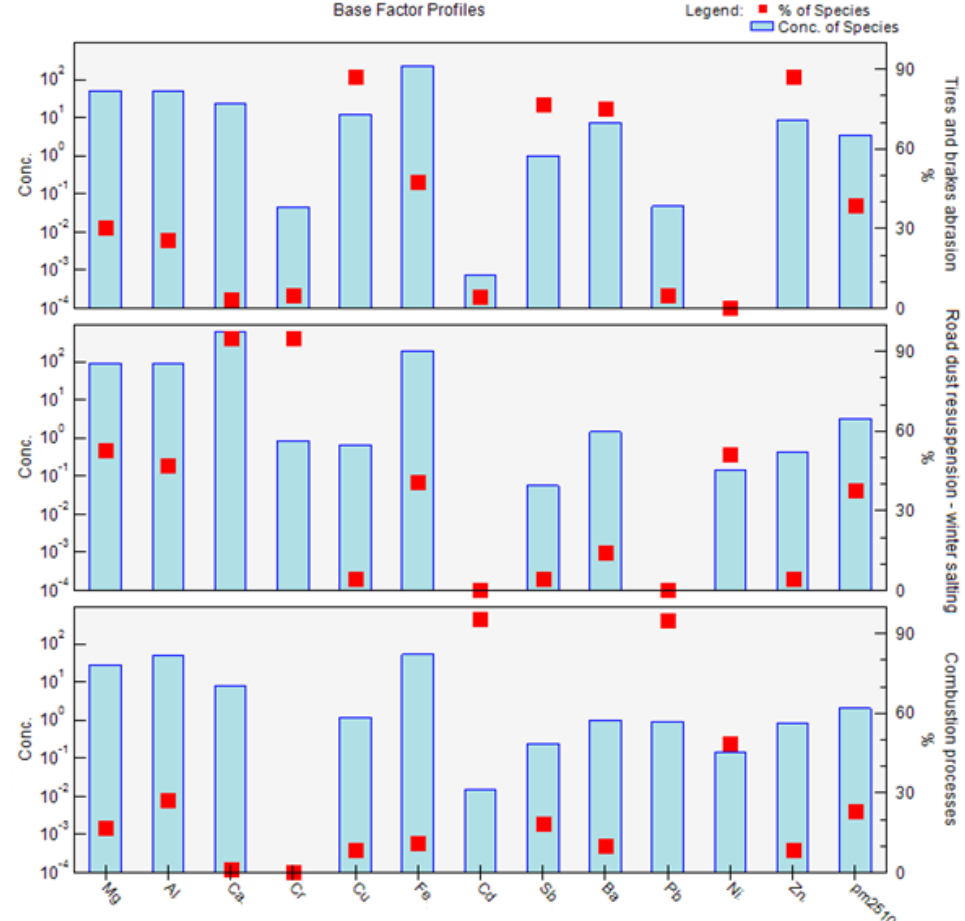
Figure 12. Factor profiles: division of elements into individual factors, and their characterization, from measurements of PM 2.5–10 taken in the city of Žilina.